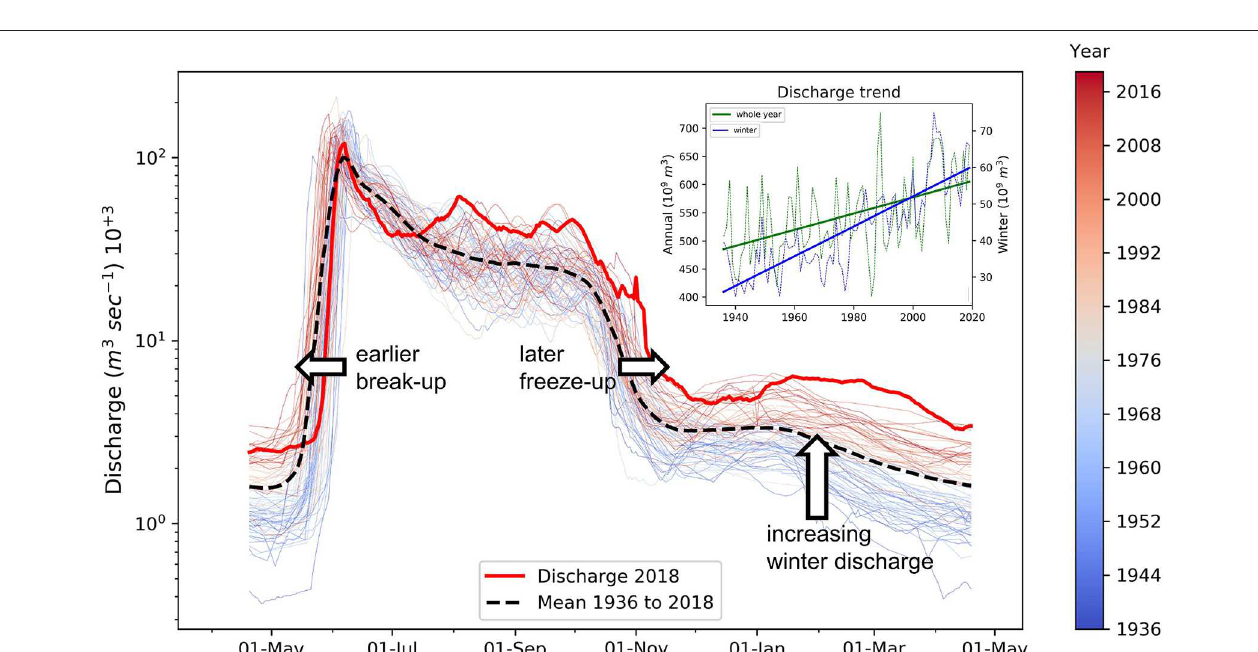
FIGURE 2 | Discharge data from Kyusyur station from 1936 to 2018. Colors from blue to red indicate the year from 1936 to 2018. The red thick solid line shows the year 2018 and the black thick dashed shows the mean of the period from 1936 to 2018. The inset figure shows the discharge flux for the whole year (green) and for November to April (blue). Discharge data: A.I. Shiklomanov (2010) 1939–2008, ArcticGRO 2009–2019.